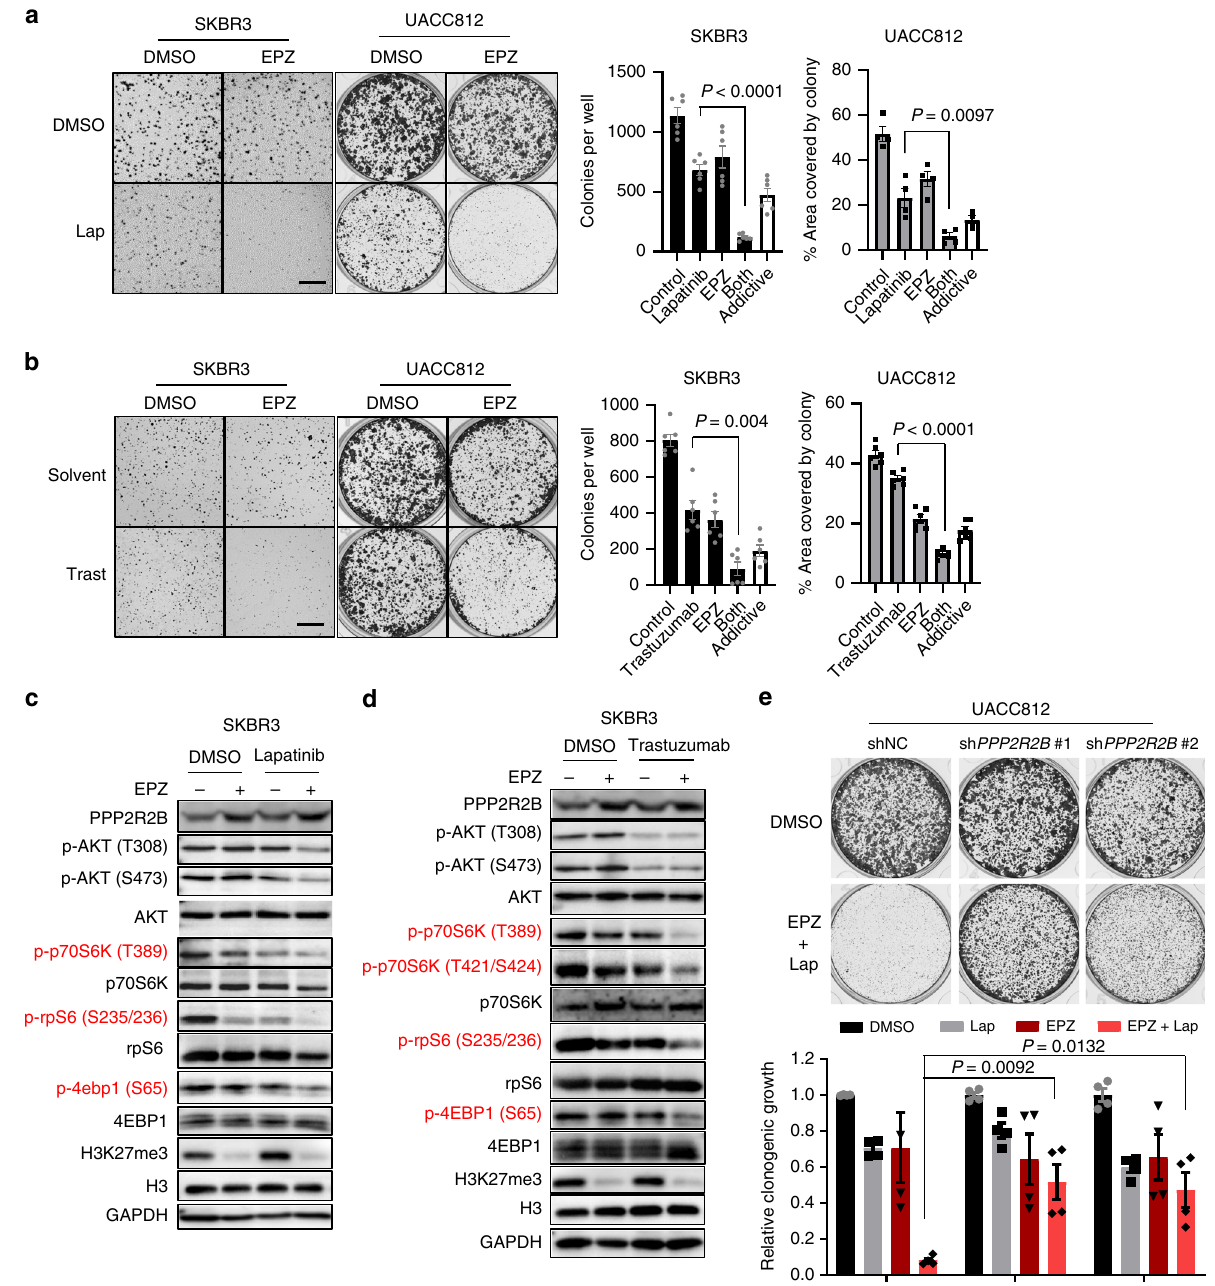
Fig. 5 EPZ and anti-HER2 combination elicits robust effect in vitro. a Representative images (left) and quanti fi cation (right) of soft agar assay with SKBR3 or clonogenic assay with UACC812 treated with DMSO, EPZ (1 µ M), lapatinib (lap; 20nM), or the combination of both. Data are expressed as mean±s.e.m. of two independent experiments performed in triplicate for SKBR3 ( n = 6) and duplicate for UACC812 ( n = 4). Scale bar: 1.5 mm. The addictive effect from the EPZ and lapatinb was computed and shown in the fi gure. b Representative images (left) and quanti fi cation (right) of soft agar assay with SKBR3, or clonogenic assay with UACC812 treated with the solvent, EPZ (1 µ M), trastuzumab (trast; 10 µ g/ml), or the combination of both. Data are expressed as mean±s.e.m. of two independent experiments performed in triplicate ( n = 6). Scale bar: 1.5mm. The addictive effect from the EPZ and trastuzumab was computed and shown in the fi gure. P values in a and b were determined with two-tailed Student ’ s t -test. c Representative western blot analysis ( n = 2) with SKBR3 treated with the solvent, lapatinib (40 nM), EPZ (1 µ M), or the combination of both. d Representative western blot analysis ( n = 2) with SKBR3 treated with the solvent, trastuzuamb (10 µ g/ml), EPZ (1 µ M), or the combination of both. Effectors downstream of mTOR were highlighted in red in c and d . e Representative images (top) and quanti fi cation (bottom) of clonogenic assay with UACC812 transduced with shNC or shRNAs against PPP2R2B and treated with DMSO, lapatinib (lap; 20nM), EPZ (1 µ M), or the combination of both. Data are expressed as mean±s.e.m. of two independent experiments performed in duplicates ( n = 4). P values were determined with two-tailed Student ’ s t -test, and corrected with Bonferroni